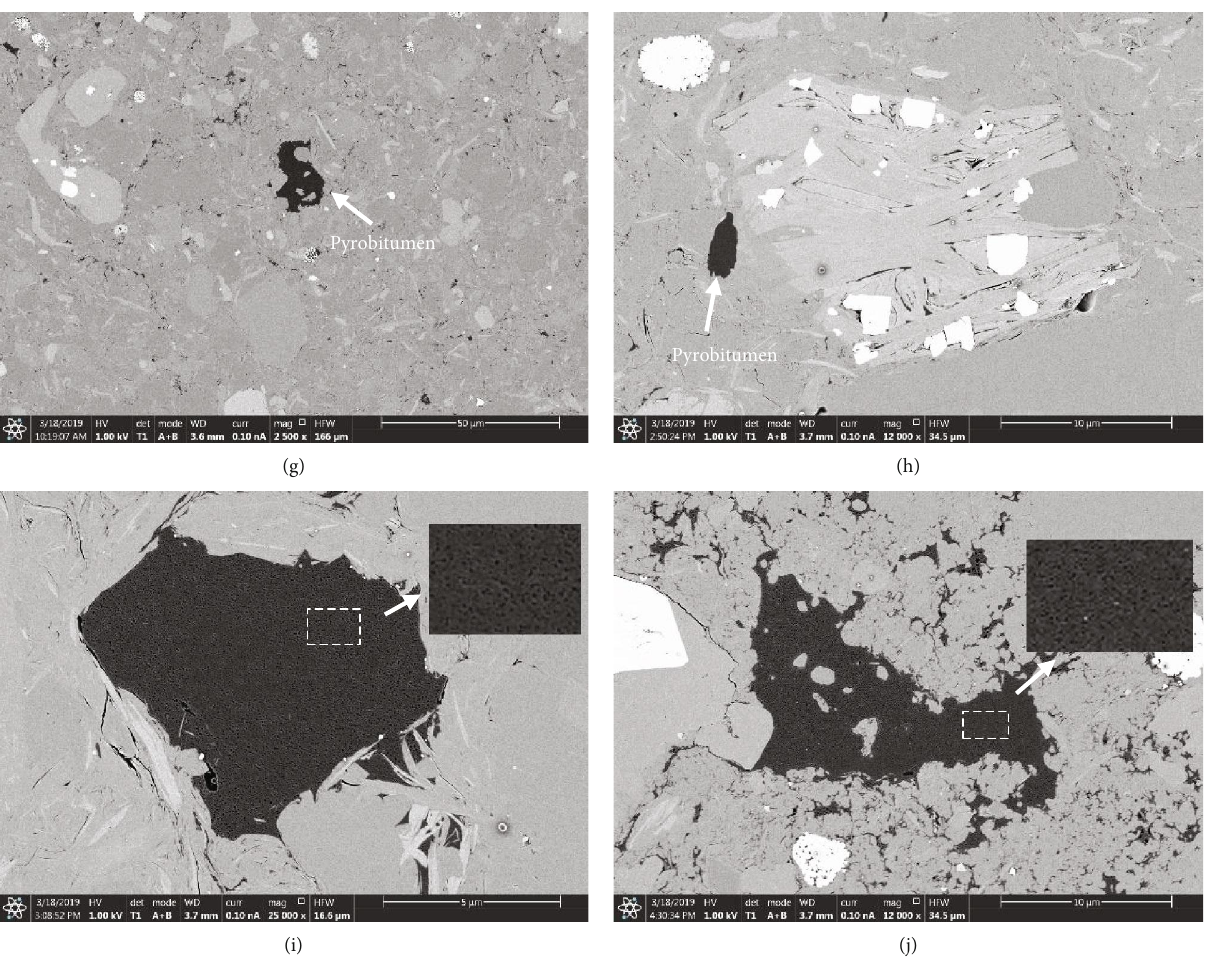
Figure 4: (a) Photomicrographs of groundmass pyrobitumen in Wufeng-Longmaxi shale samples under a microscope in incident white light under oil immersion. (b) Scanning electron microscopy (SEM) of the pyrobitumen disseminated in the shale matrix in the same area as (a). (c, d) Pyrobitumen accumulated in interparticle pores and microfractures. (e, f) Pyrobitumen fi lling the mineral outline. Zooclast and pyrobitumen distributing along the shale matrix. (g, h) Single large pyrobitumen particle of several micrometers in diameter. The larger rectangles in (i, j) are enlarged areas of the related smaller rectangles. This type of pyrobitumen consists of bacteria-like